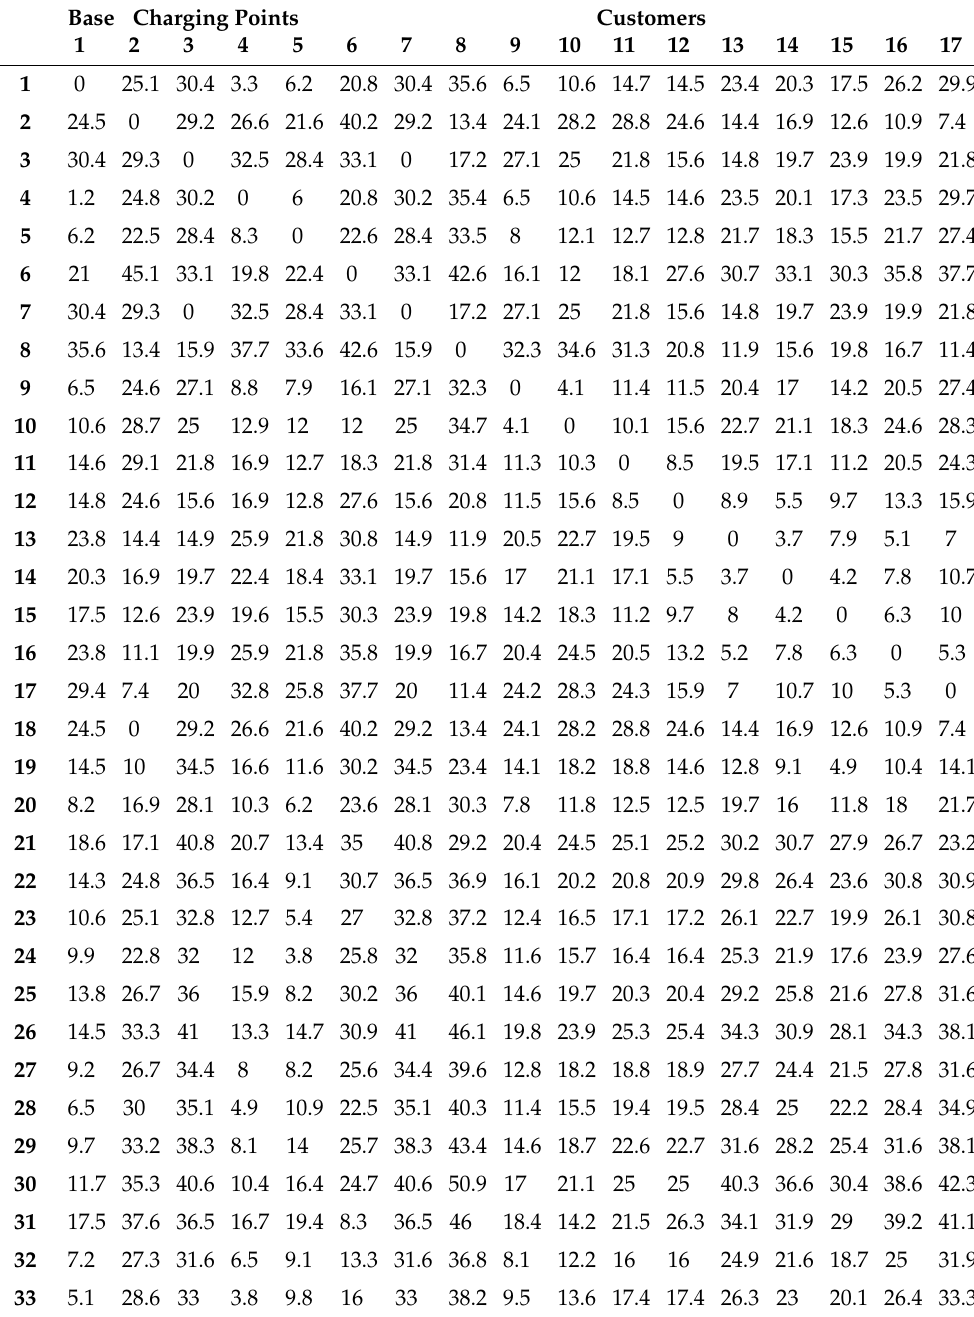
Table A1. Distance matrix for exemplary study—part 1—destination points